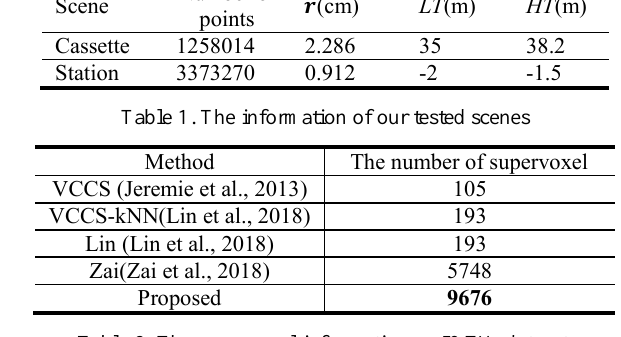
Table 2. The supervoxel information on IQTM dataset.